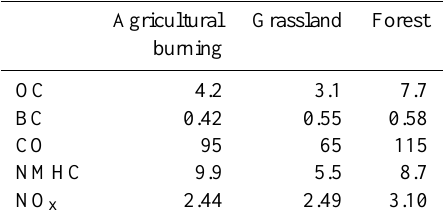
tions of the stations. The observational (or simulated) data for the selected sites in the Moscow region for a given day were combined by